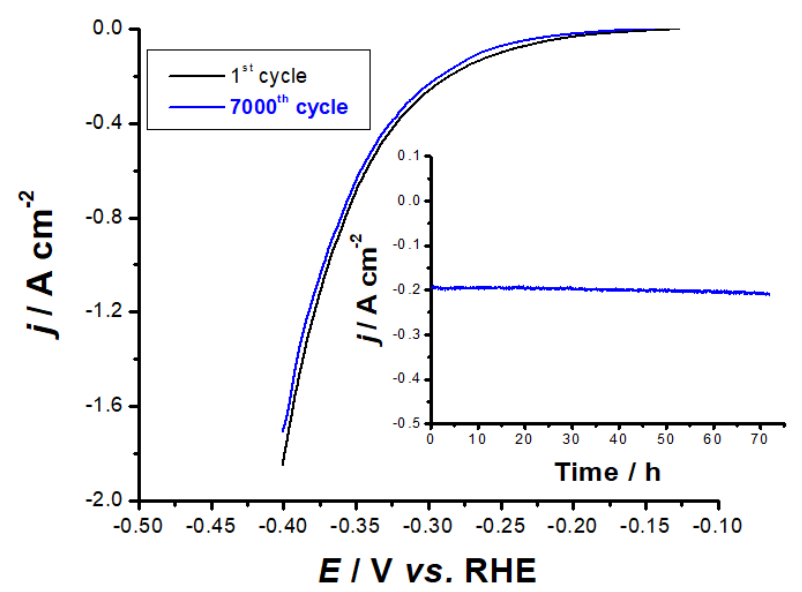
Figure 13. Long ‐ term stability test recorded for the best performing electrocatalyst, namely GC − MnC (0.8 mg cm − 2 ) in 0.1 M KOH solution at room temperature for the HER. LSV measurements were conducted at a scan rate of 50 mV s − 1 . Inset—chronoamperometry measurements performed on the catalyst at a constant applied potential of − 0.4 V vs. RHE.